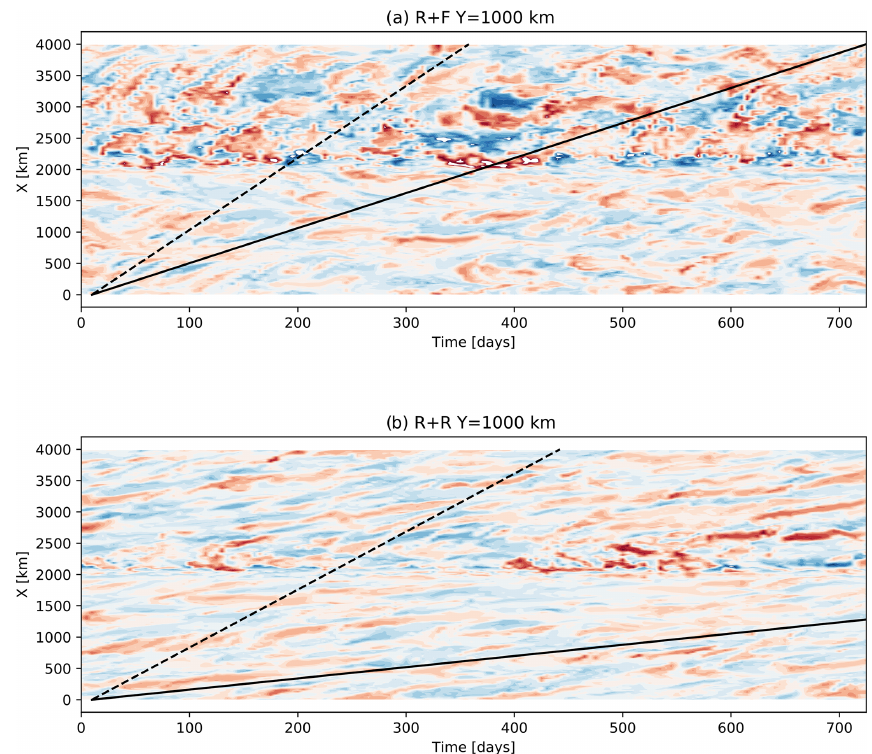
Figure 13. Hovmöller diagram of surface temperature anomalies at Y = 1000km as in Abernathey and Cessi (2014) built using 5d averaged model outputs for a 2-year period. The dashed line indicates the zonal surface velocity and the continuous line indicates the barotropic